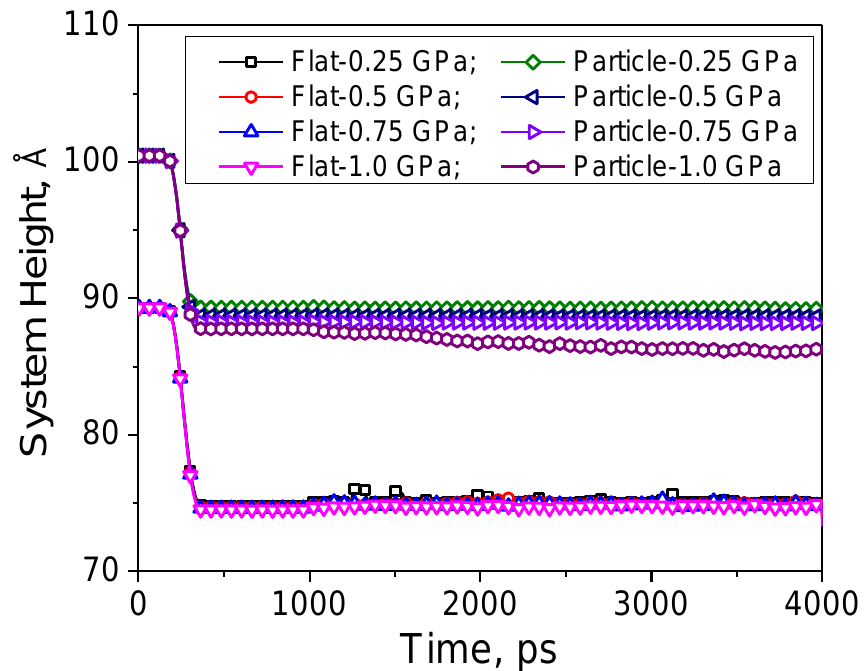
Figure 3. Comparison of the system height evolution history against the simulation time under various normal loads between the flat and particle models.